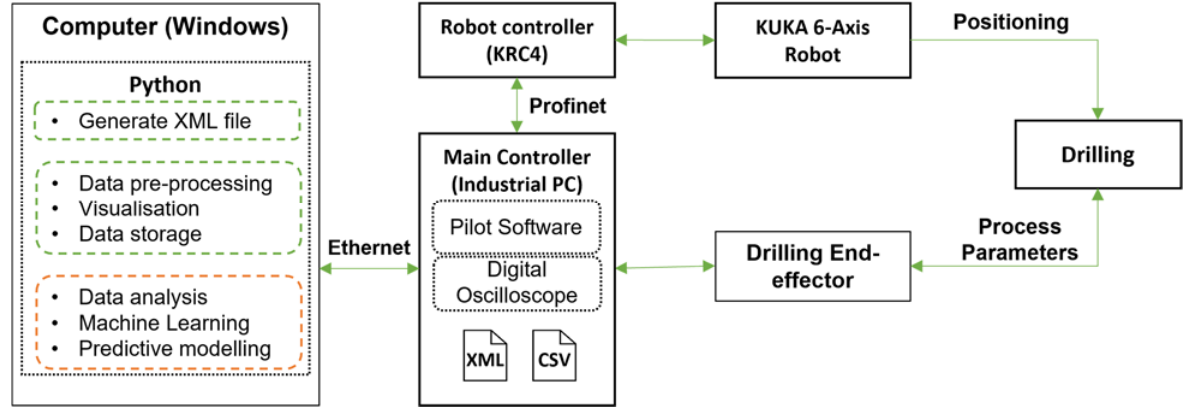
Figure 7. Process flow for robotic drilling process execution and monitoring.